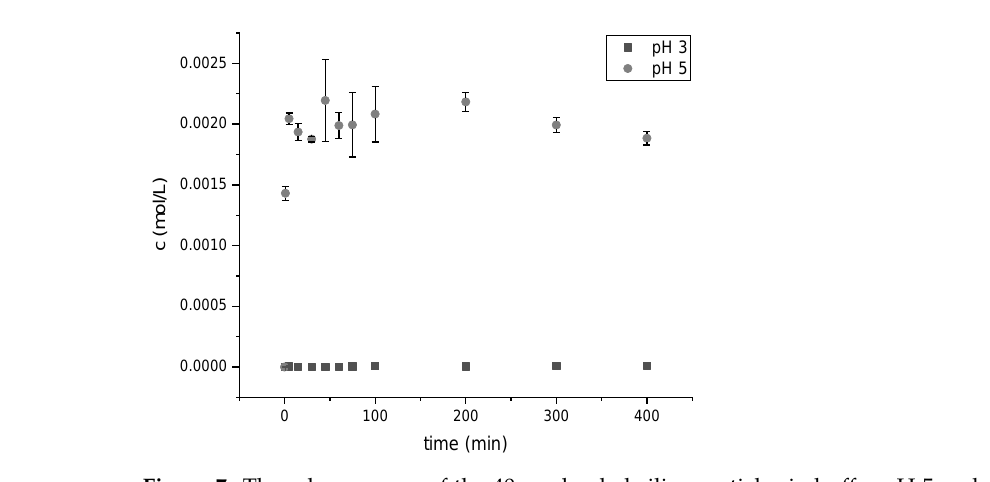
Figure 7. The release curve of the 40 mg loaded silica particles in buffer pH 5 and pH 3, UV–Vis spectra (Lambda 2, PerkinElmer) wavelength 300–190 (nm), n = 3 (232 nm pH 5, 230 nm pH 3).